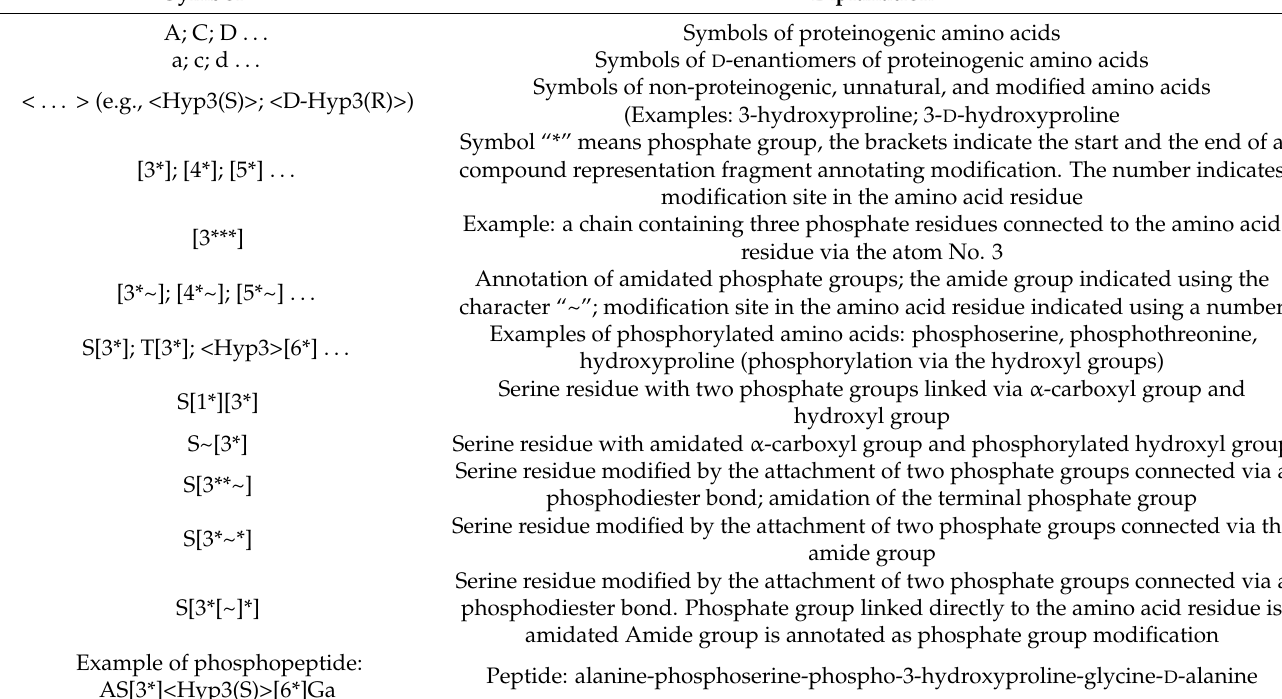
Table 2. Symbols used to annotate amino acids and phosphate